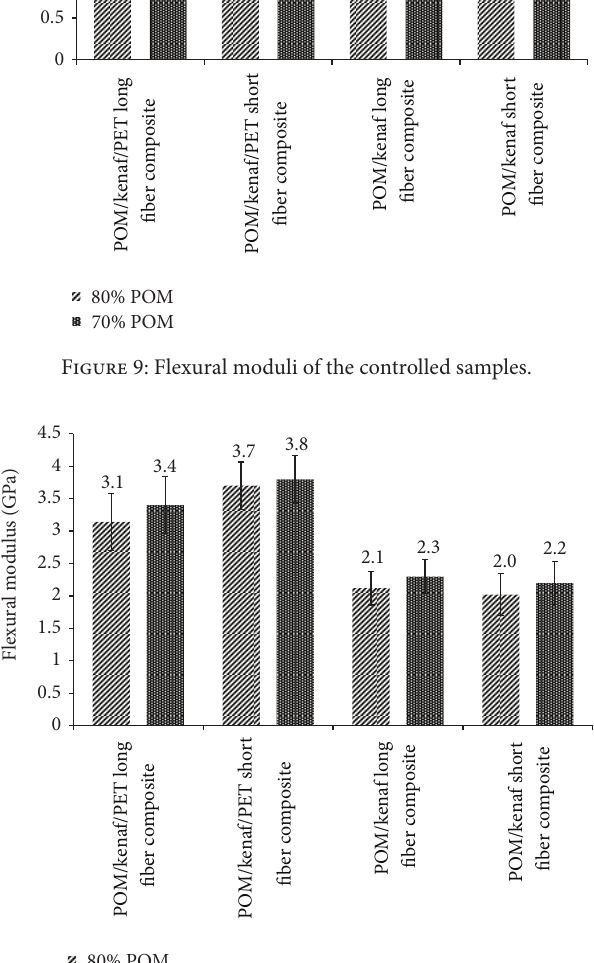
Figure 10: Flexural moduli of the weathered samples.